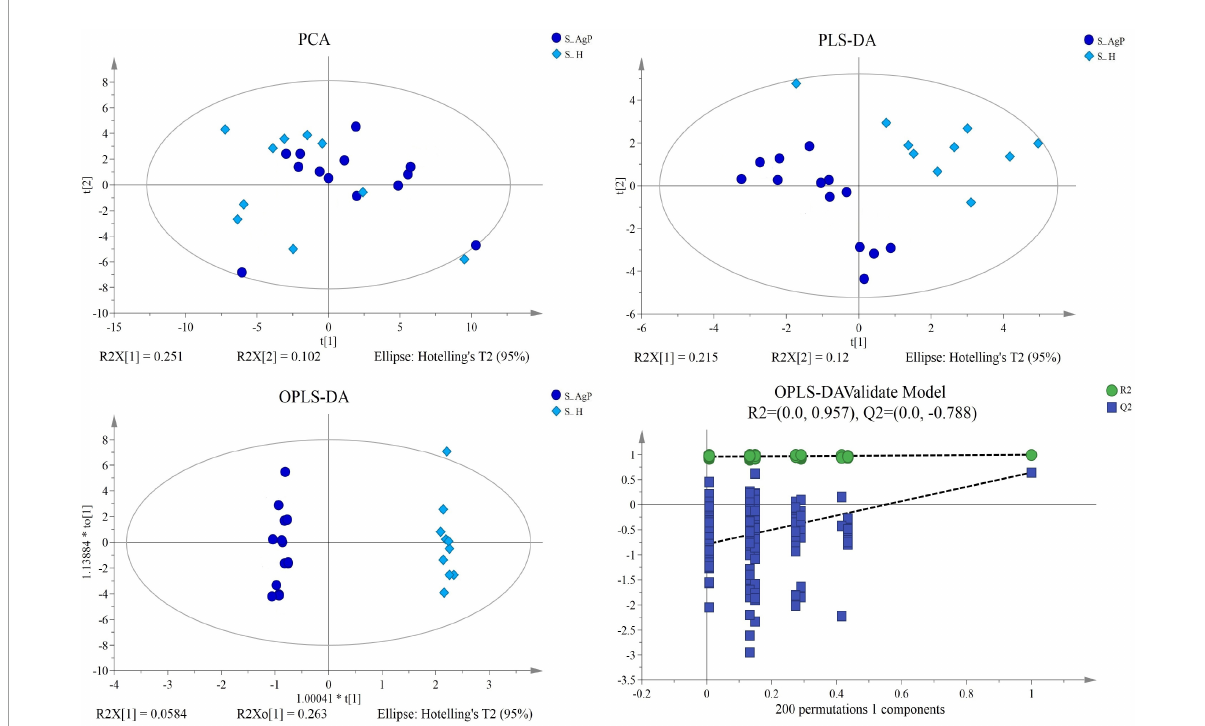
FIGURE4 Dissimilarity in salivary metabolic signatures between AgP and PH. PCA analysis (A) , PLS-DA analysis (B) , OPLS-DA analysis (C) , and response permutation testing of OPLS-DA (D) . PCA, principal components analysis; PLS-DA, partial least-squares discriminant analysis; OPLS-DA, orthogonal partial least-squares discriminant